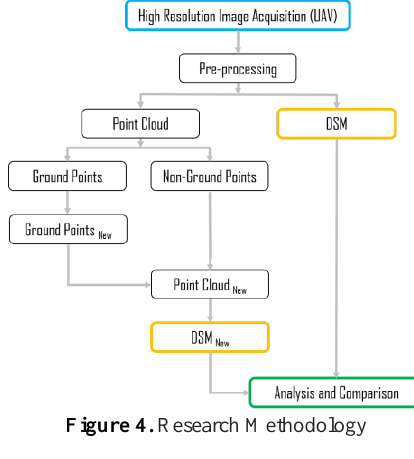
Figure 4. Research